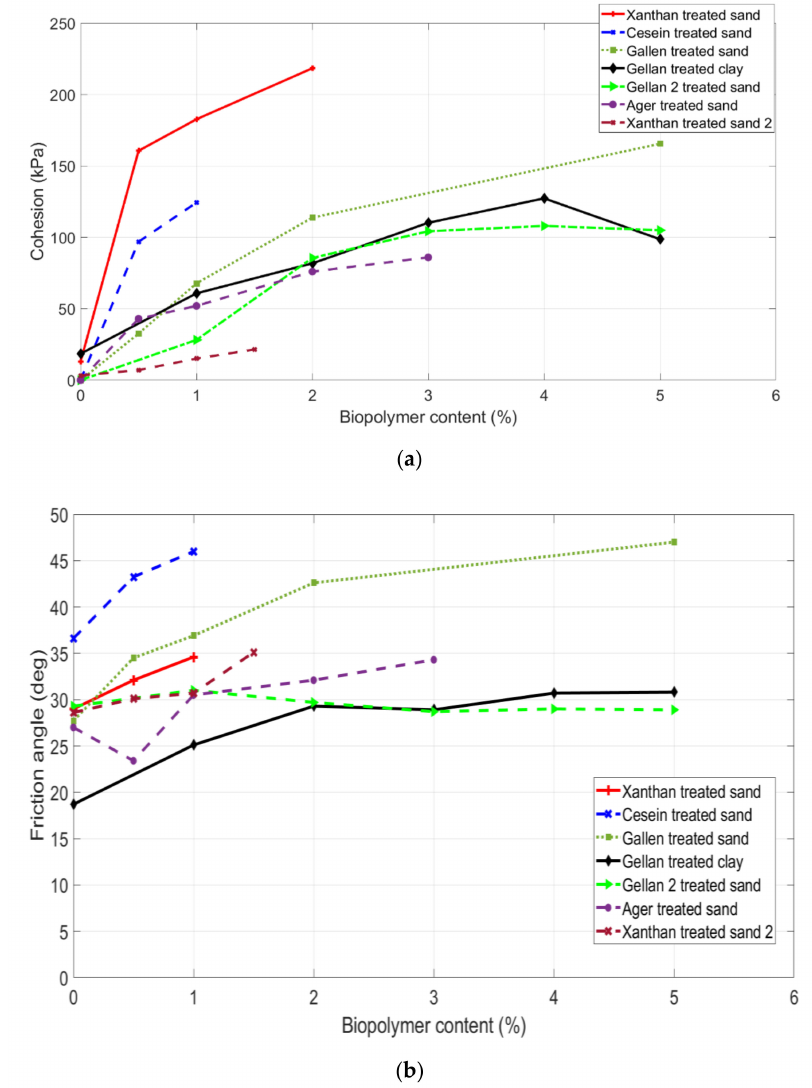
Figure 6. Variation of shear strength parameters of biopolymer-treated soils: ( a ) cohesion, ( b ) friction angle